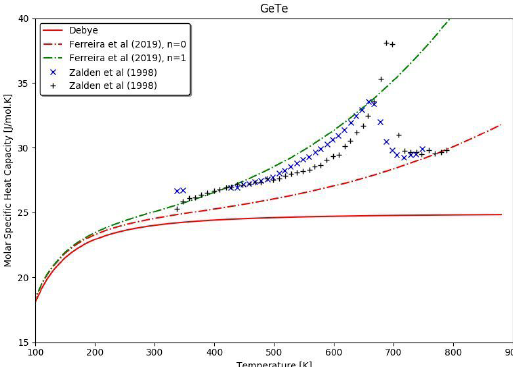
Figure 10. Comparison of the molar heat capacity of Germanium Telluride (GeTe) by carrying out Debye, Ferreira’s model 17 , and experimental data Zalden et al. 28 .